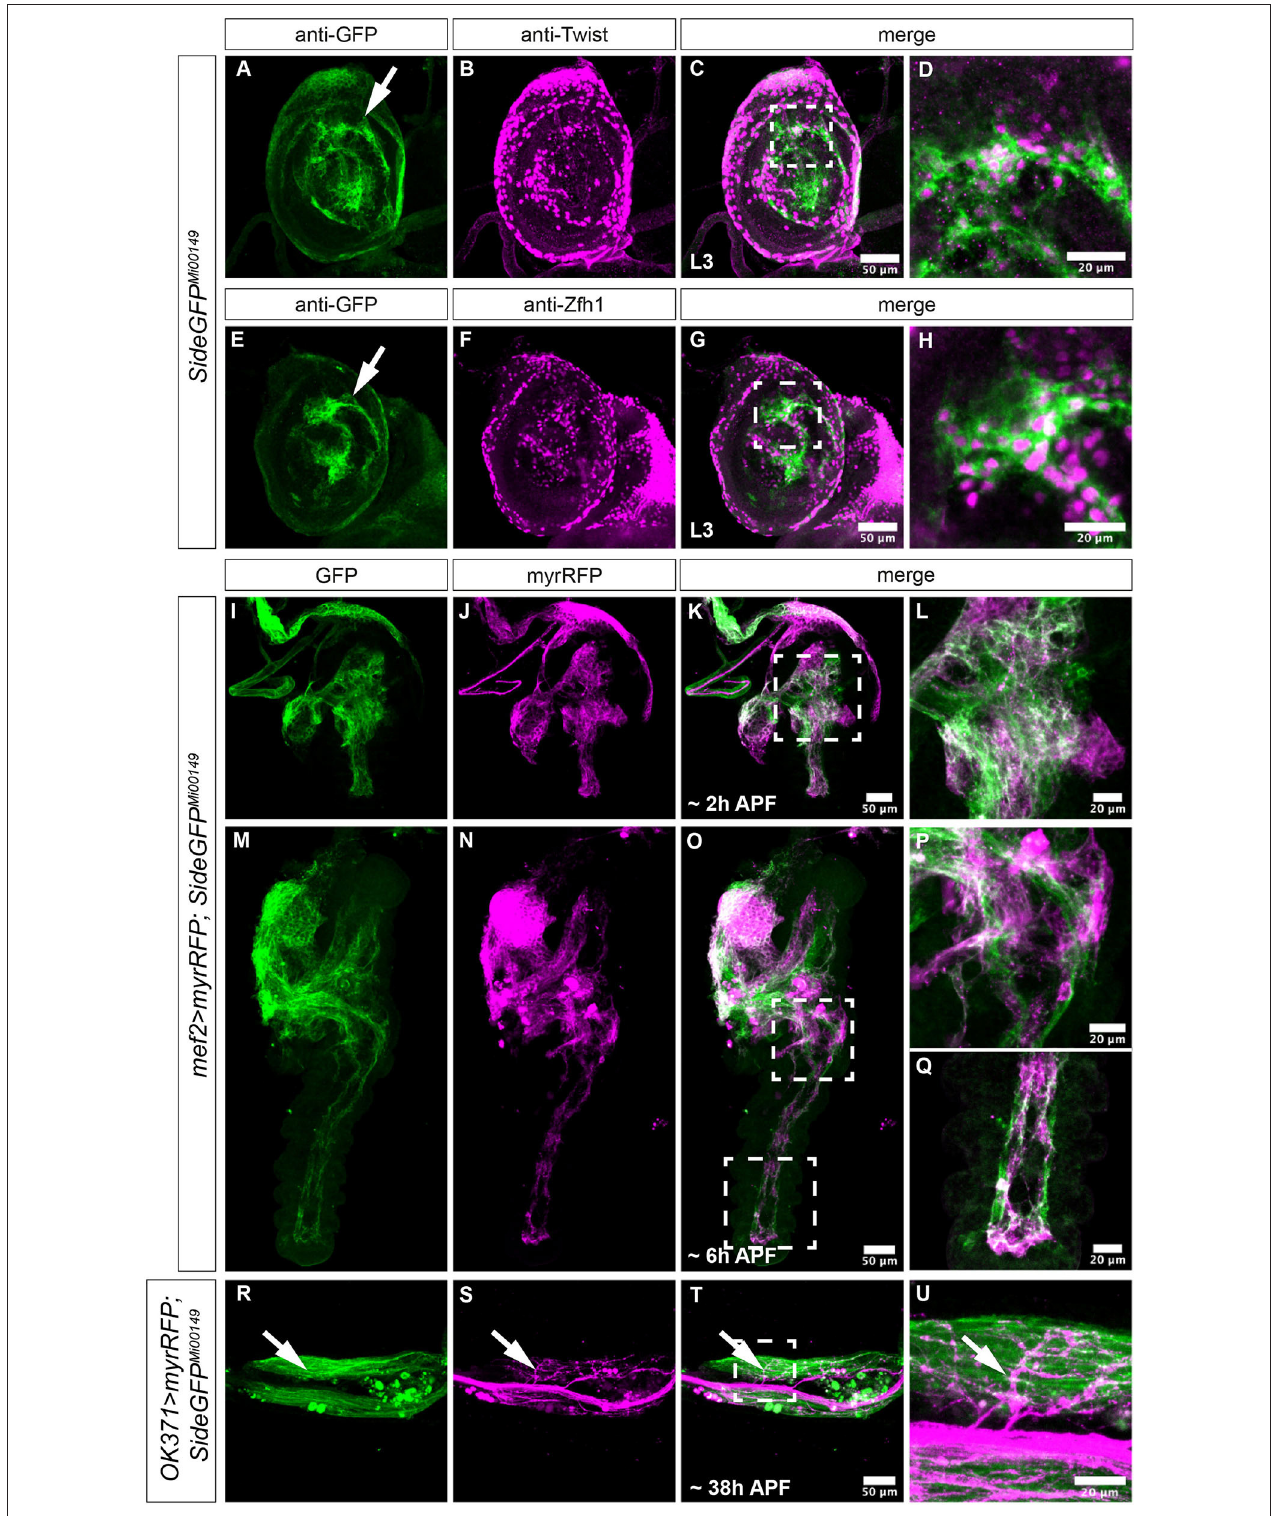
FIGURE 1 | Expression of Side in Drosophila imaginal discs. (A–U) Projections of confocal micrographs acquired from dissected leg imaginal discs oflate SideGFP Mi 00149 thirdinstarlarvaeandearlypupaeoftheindicatedgenotypes.Whiteframesmarkregionsenlargedinnewmicrographsin D,H,L,P,Q,U . (A,E) Inleg